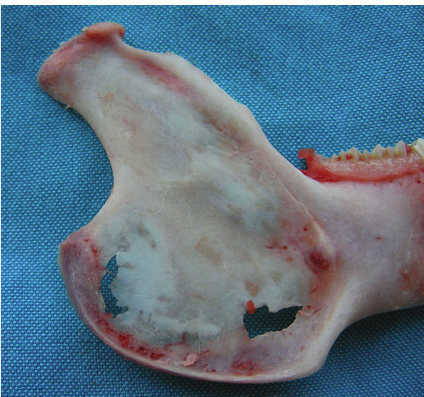
Figure 1: Subperiosteally dissected hemimandible of the rabbit including condyle.